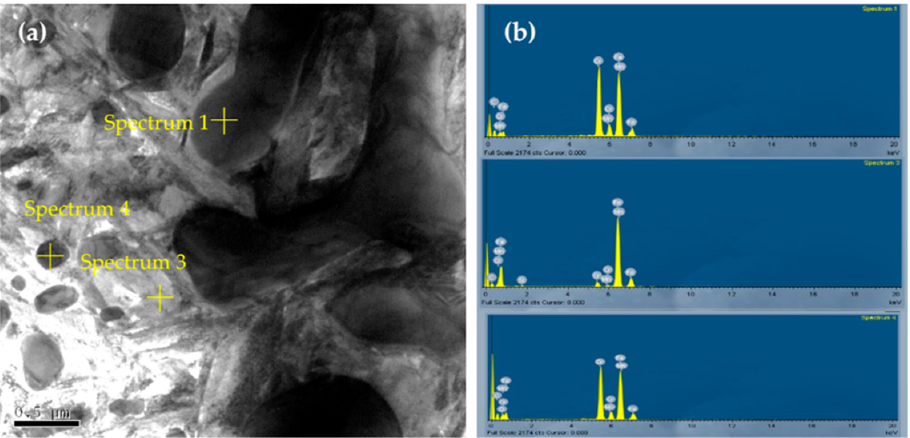
Figure 8. ( a ) Bright field image of HT sample; ( b ) EDX spectra corresponding to positions (spectrum 1) a dark primary carbide; (spectrum 3) a secondary carbide and (spectrum 4) a needle shape of a matrix.